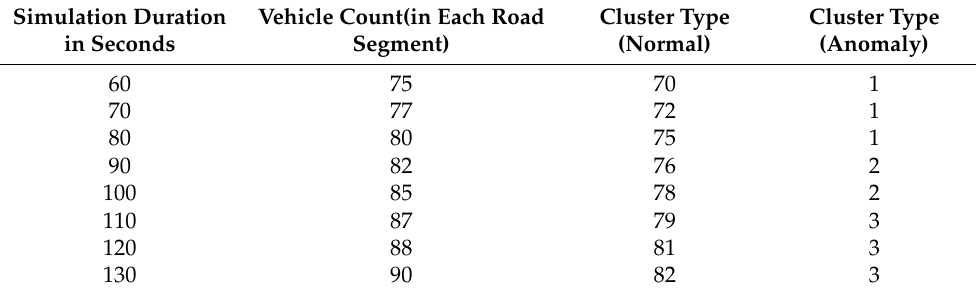
Table 3. Clustering Outcomes of DBSCAN and ML methods for accident detection. Simulation Duration in